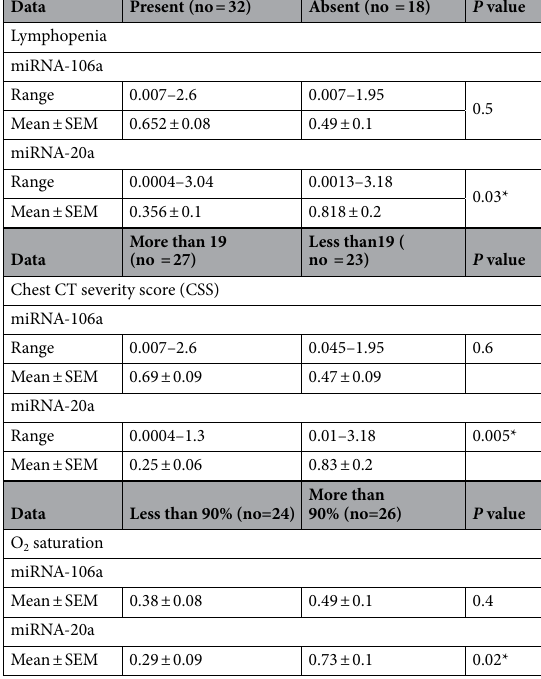
Table 1. The mean value ± SEM of serum miRNA-106a and miRNA-20a expression levels in relation to lymphopenia, chest CT severity score (CSS) and O 2 saturation in COVID-19 patients. *Significant level at P value <